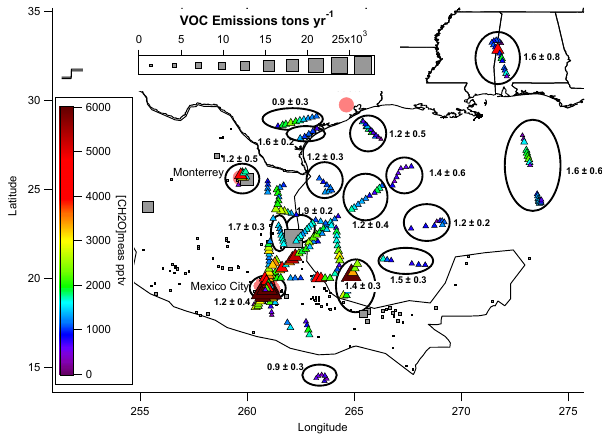
Fig. 9. Boundary layer (radar altitude < 2km) CH 2 O TDLAS measurements on the hydrocarbon time base during 1st phase of INTEX-B. Mixing ratios (triangles) are colored and sized by their values. To preserve resolution the mixing ratio scale extends to only 6ppbv. Several measurements are greater than this, includ- ing: (1) a large plume over the Gulf of Mexico (lat. = 20.2, long. = 264.9, CH 2 O = 9ppbv); (2) and numerous points over Mexico City extending up to CH 2 O values of 14.6ppbv. The filled gray squares show VOC point sources sized by their emission values in tonsyr − 1 . Measurements, which are grouped into geographic flight segments (see text), are highlighted by circles. The average and standard deviation of the measurement/box model ratios for each flight segment are given adjacent to each circle. The Tampico VOC emission (latitude = 22.3, longitude = 262.2) is 27700tonsyr − 1 , which is more than the sum of the largest 78 Mexico City VOC emissions (sum = 27024 tonsyr − 1